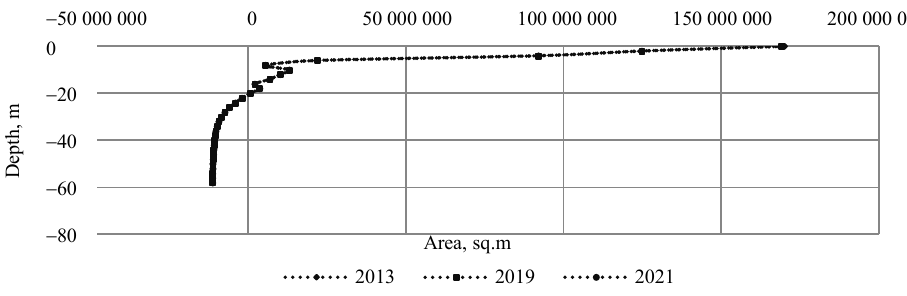
Fig. 4. Volume curve of Svitiaz Lake (dependence between water volume and its